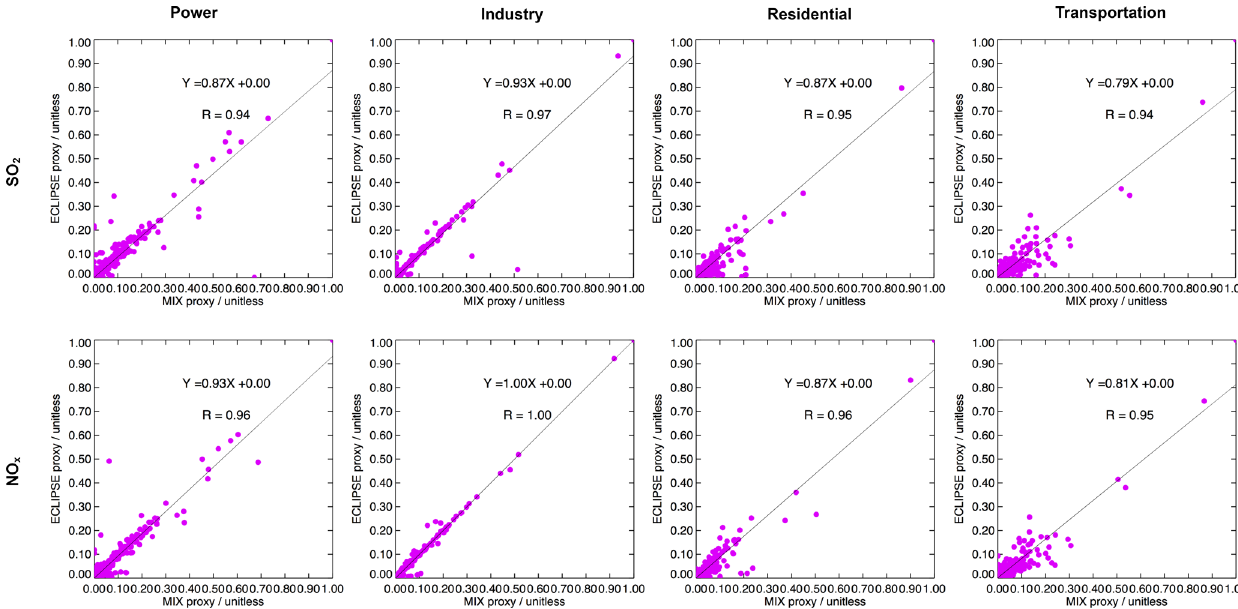
Figure 4. Emission distribution ratios within provinces in China in 2010 at 0 . 5 ◦ × 0 . 5 ◦